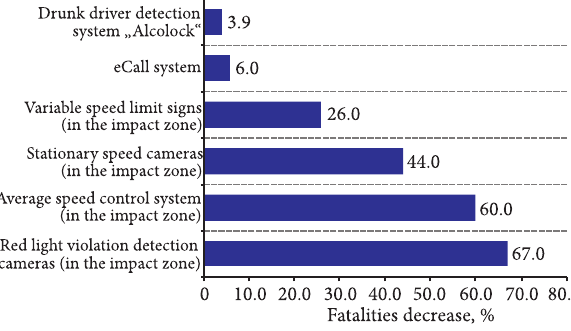
Fig. 1. ITS effect on a decrease in road fatalities criterion evaluated by meta-analysis method